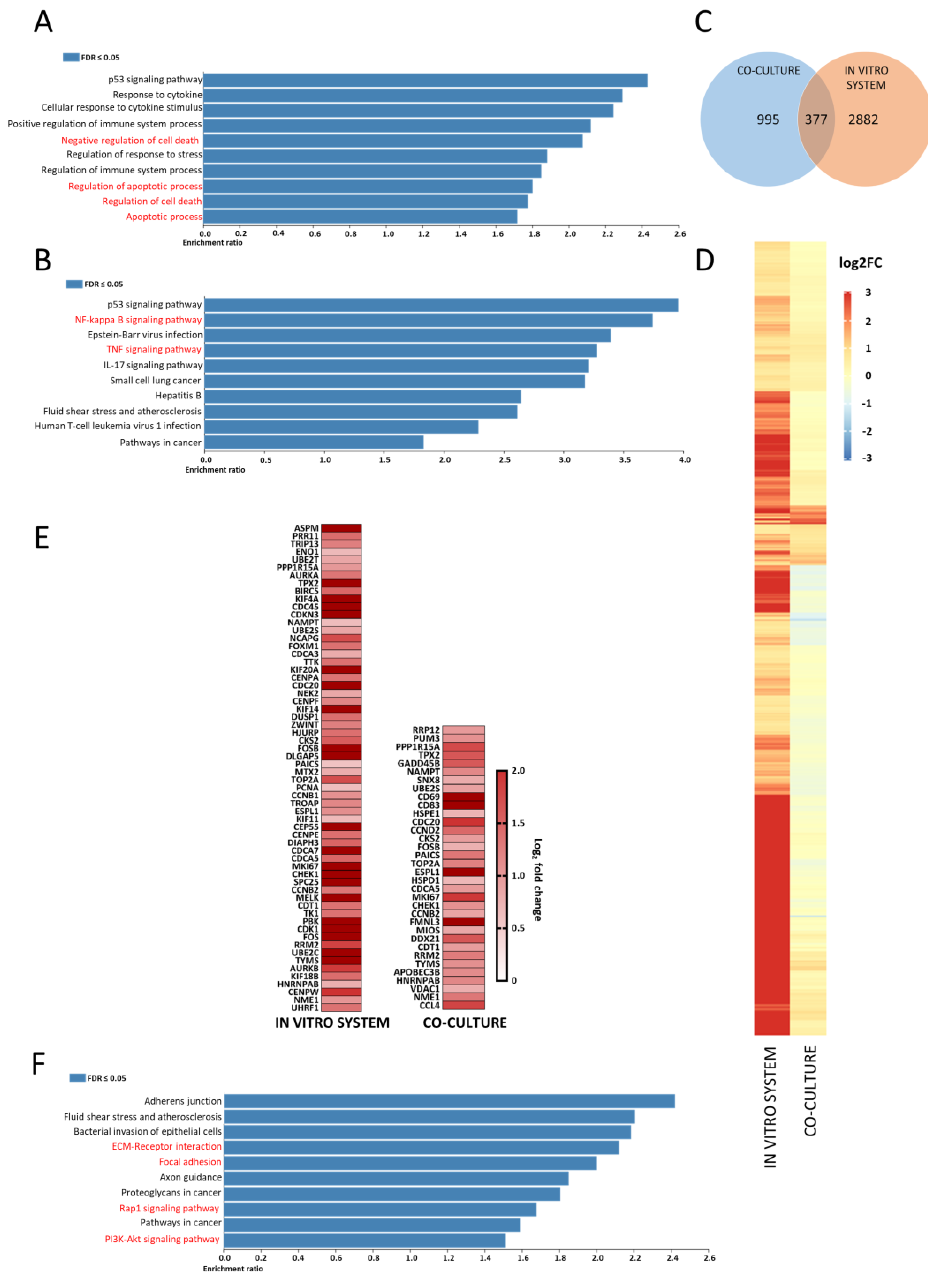
Figure 1. Fibroblast co-culture and endothelial cell in vitro system produce distinct transcriptomic signatures. ( A ) The top 10 overrepresented pathways in the differentially expressed gene list for CD40L-fibroblast co-cultured cells in the biological processes and ( B ) the KEGG pathway databases. ( C ) Shows the overlap in upregulated genes between CD40L co-culture and in vitro circulatory system. ( D ) Shows a heatmap displaying the significantly upregulated genes in the in vitro circulatory system and the corresponding expression in the co-culture system. ( E ) Shows a heatmap representing the overlap between the differentially upregulated genes between migratory cells in the circulating system, the CD40L co-culture system and the 134 previously published genes upregulated in lymph node resident CLL cells. ( F ) The top 10 overrepresented pathways in the differentially expressed gene list for in vitro system migratory cells in the KEGG pathway database. Red text represents gene sets of interest.